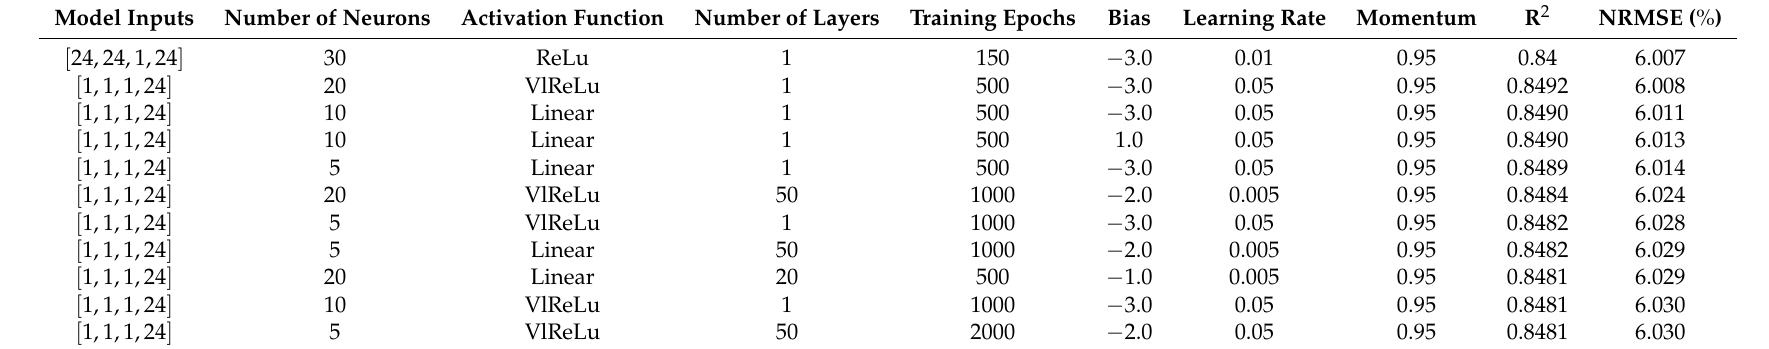
Table 3. Top 10 results among the deep highway networks (DHN) models.